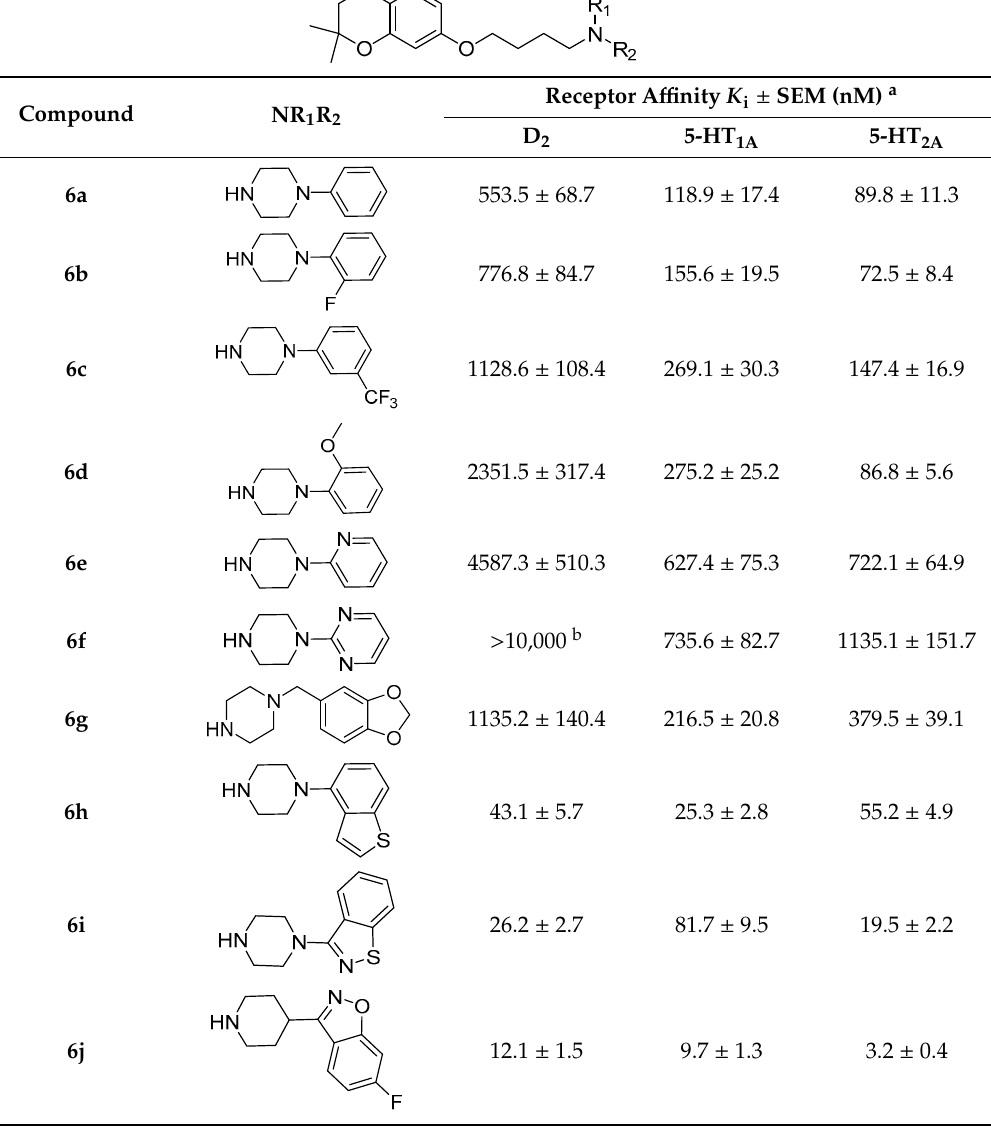
Table 1. Binding Affinities for D 2 , 5-HT 1A , and 5-HT 2A Receptors of Compounds. Compound